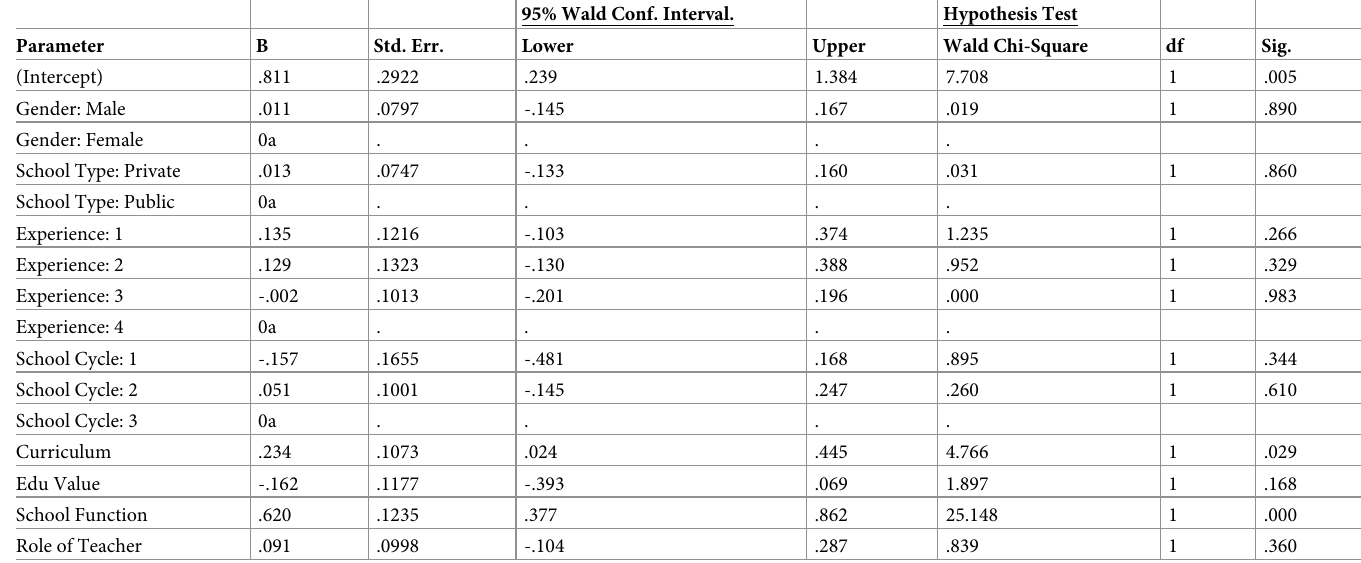
Table 15. Generalized Linear Model fitting for the dependent variable of teaching method with that of independent covariates and categorical variables. 95% Wald Conf.